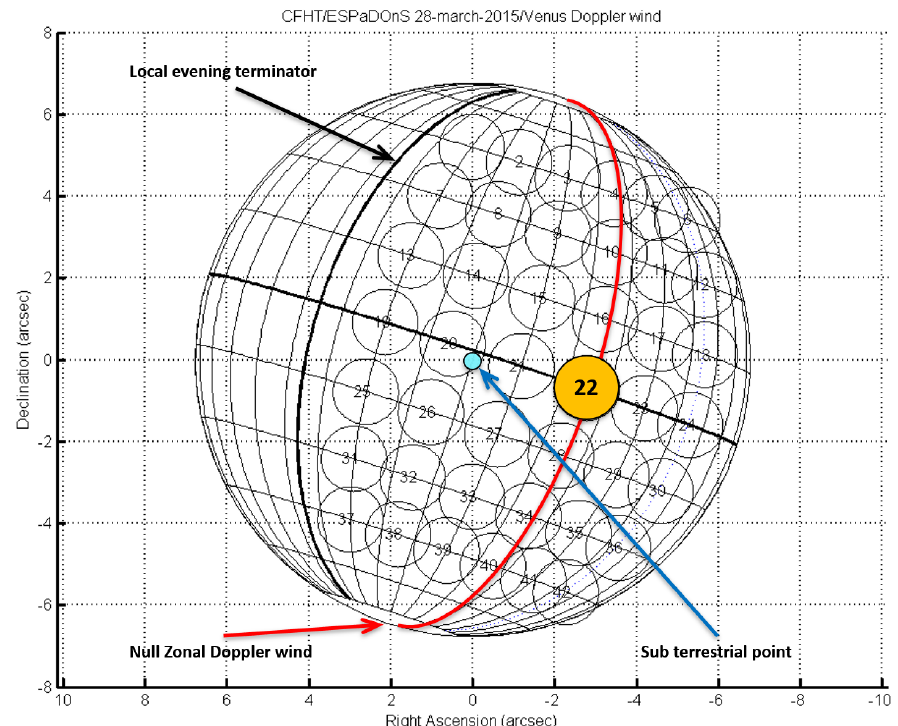
Figure 1. Aspect and angular size of Venus as seen from Earth on 28 March 2015, 00h UTC. RA and DEC axes are in arcsec. Celestial North is up. Red solid line in the half-phase angle (HPA) meridian at [ φ − φ E ] = Φ /2 ∼ 27 ◦ ; sub − Earth point as a blue circle; local evening terminator is noted as a thick solid grid line west of central meridian. The grid has steps of 15 ◦ latitude and 10 ◦ longitude. The reference point 22, used for the spectral calibration, is the as orange solid circle (0 ◦ latitude and 25 ◦